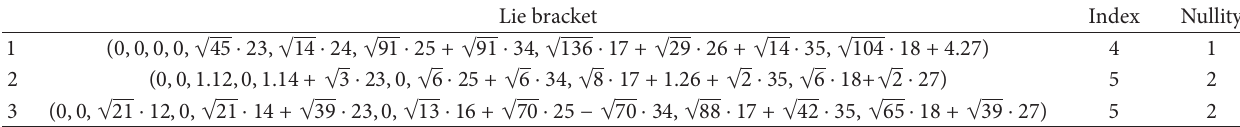
Table 3: The 9-dimensional nilsoliton metric Lie algebras of nullities 1 and 2. Lie bracket